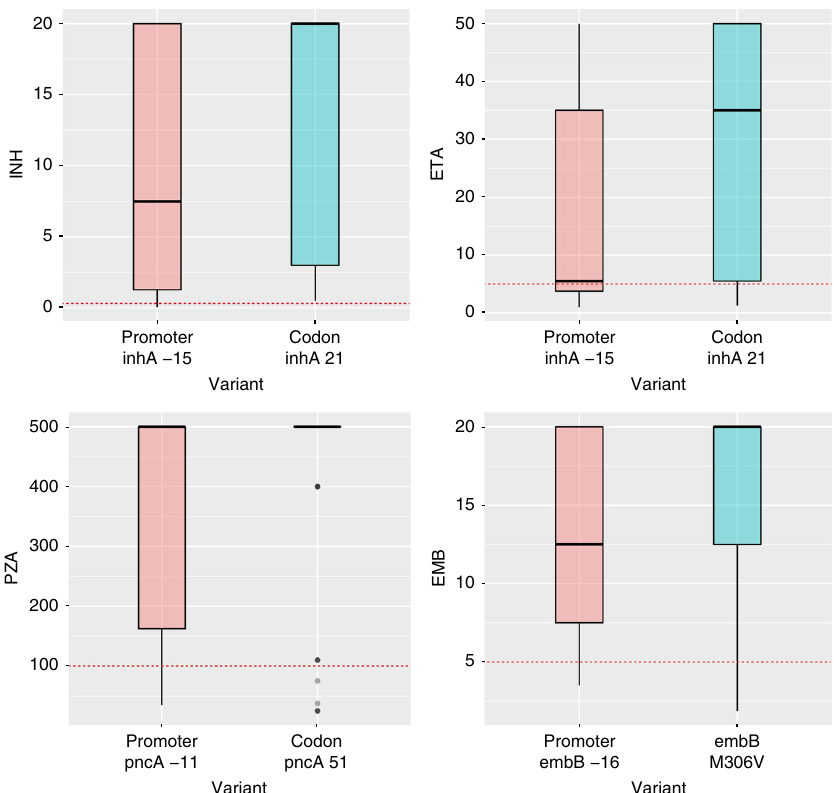
Fig. 2 Promoter vs gene body mutations and their effect on MIC ( y axis in mg per L) for four drugs ( n = 1452). Wilcoxon rank sum test comparing each pair was signi fi cant at p < 0.01. For reference critical resistance testing concentration is 0.2 mg per L for INH, 5 mg per L for ETA, 100 mg per L for PZA, 5 mg per mL for EMB and indicated by the horizontal dotted line. Figure 2 can be regenerated using code in Supplementary Data 8 that will refer to data items provided in the Source Data fi le (compressed source data